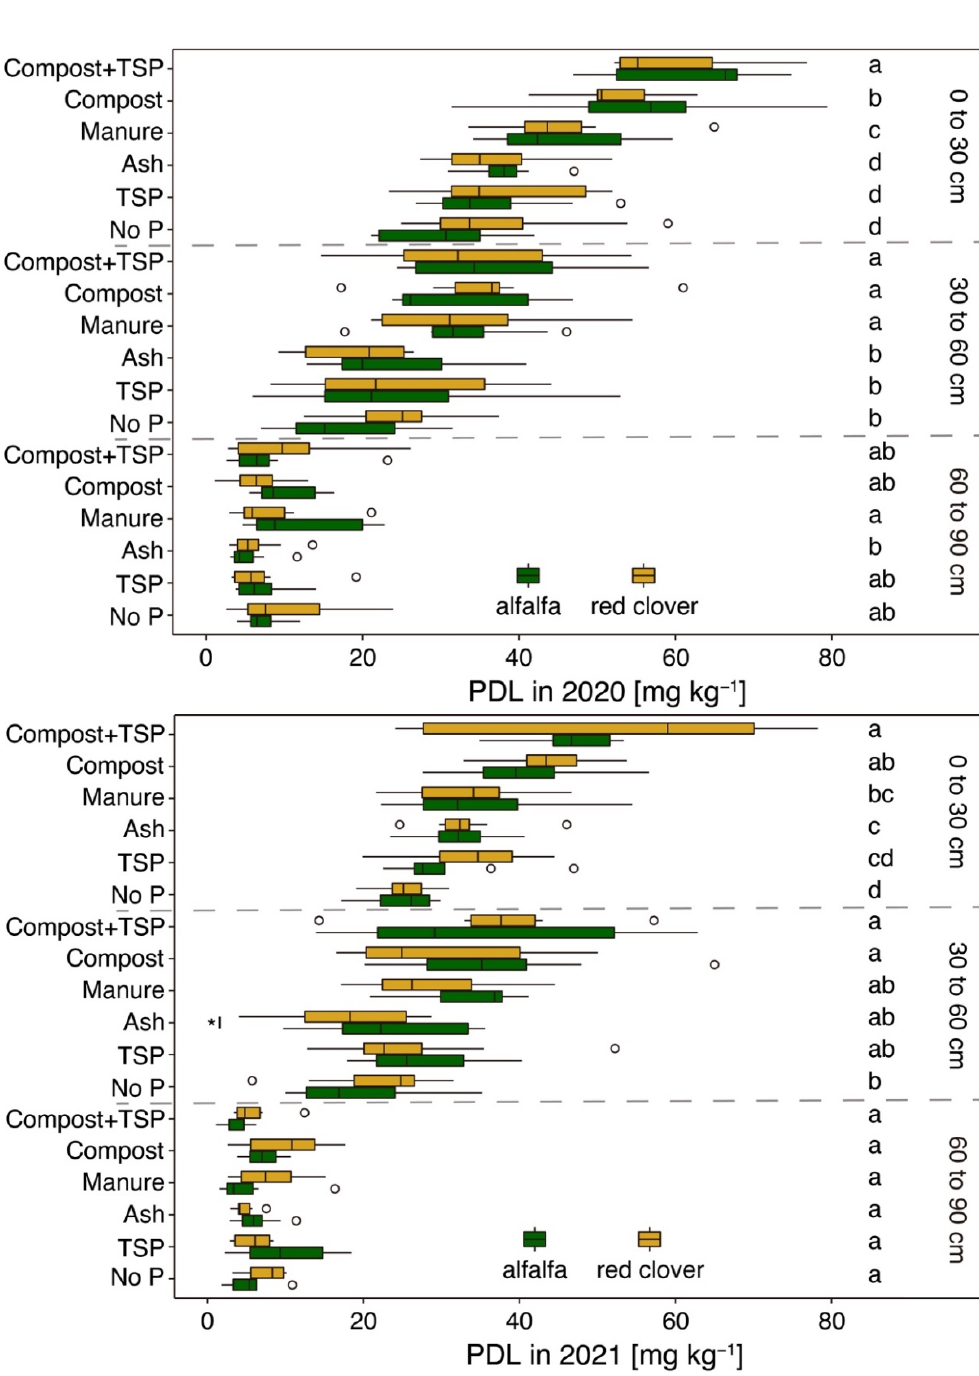
Figure 8. Double lactate extractable phosphorus (Pdl) content of soil samples taken in autumn of 2020 and 2021 in three soil depths (0 to 30, 30 to 60, and 60 to 90 cm) of the six studied treatments (no P, TSP, ash, manure, compost, and compost + TSP) with cultivation of alfalfa (green) and red clover (brown). Letters indicate a significant difference between treatments (based on average of plant species) within the same depth (Duncan’s new multiple range test with p < 0.05). Whiskers and asterisks indicate a significant interspecific difference between the respective treatments. Mean ± standard deviation (n = 8).